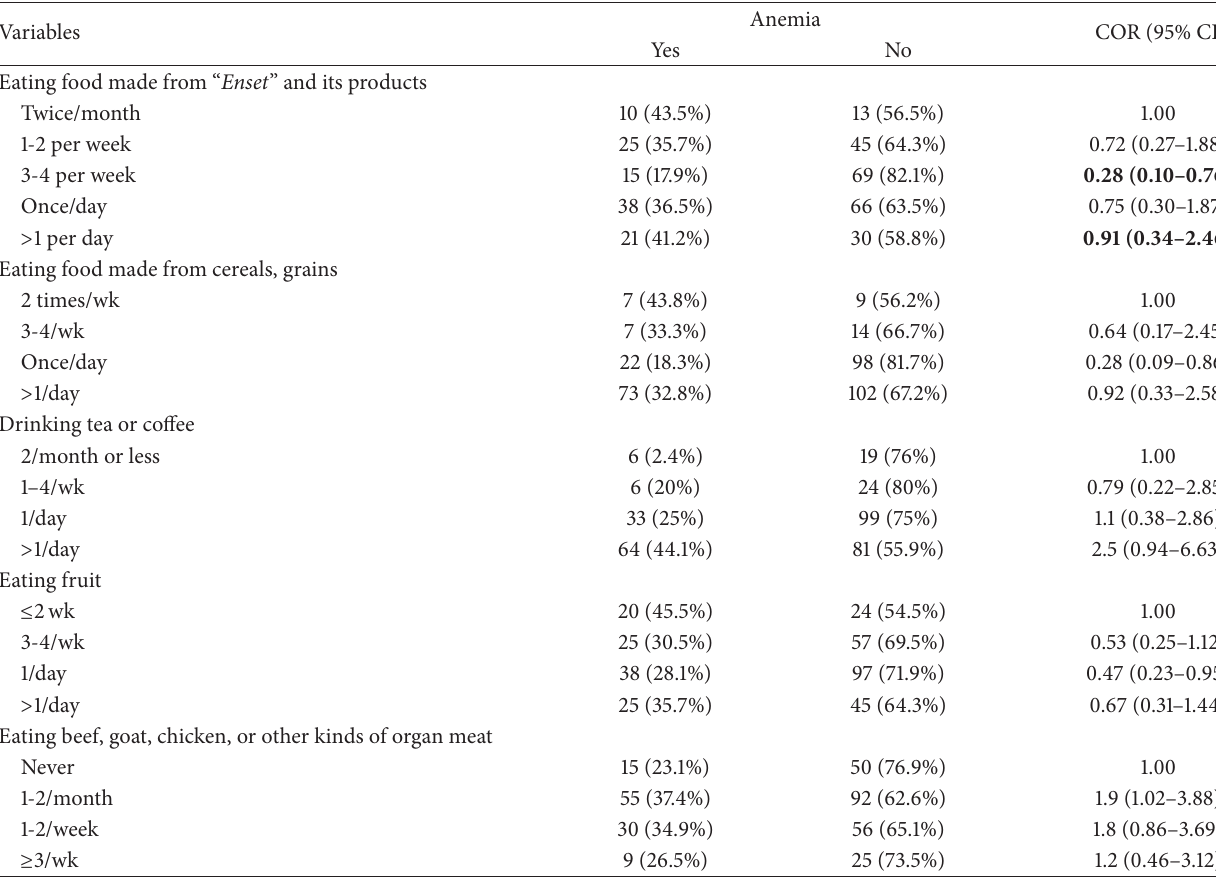
Table 6: Dietary habits associated with anemia in pregnancy among ANC attendees in government health institutions of Arba Minch town from February to April 2015 ( 𝑛 = 332